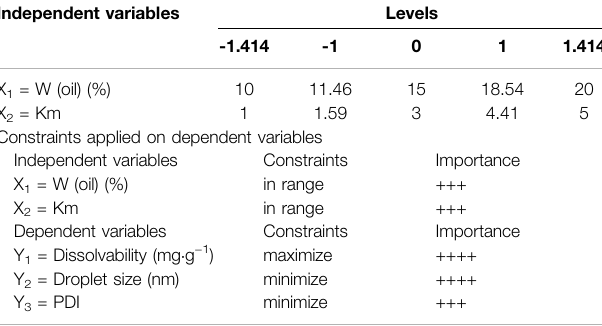
TABLE 2 | Selected independent variables and their levels. Independent